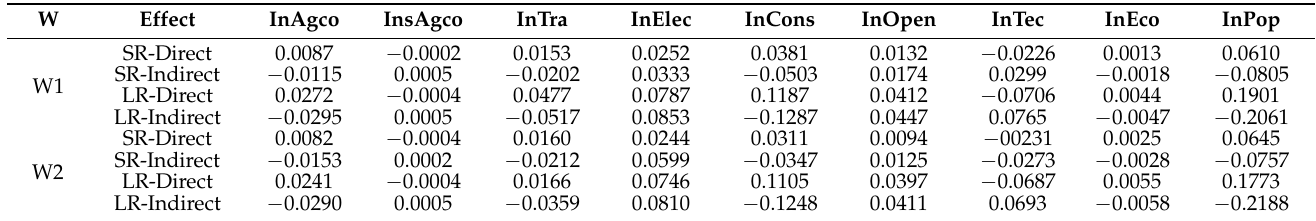
Table 5. Decomposition results of Agco influence on haze pollution under matrix 1 and 2.